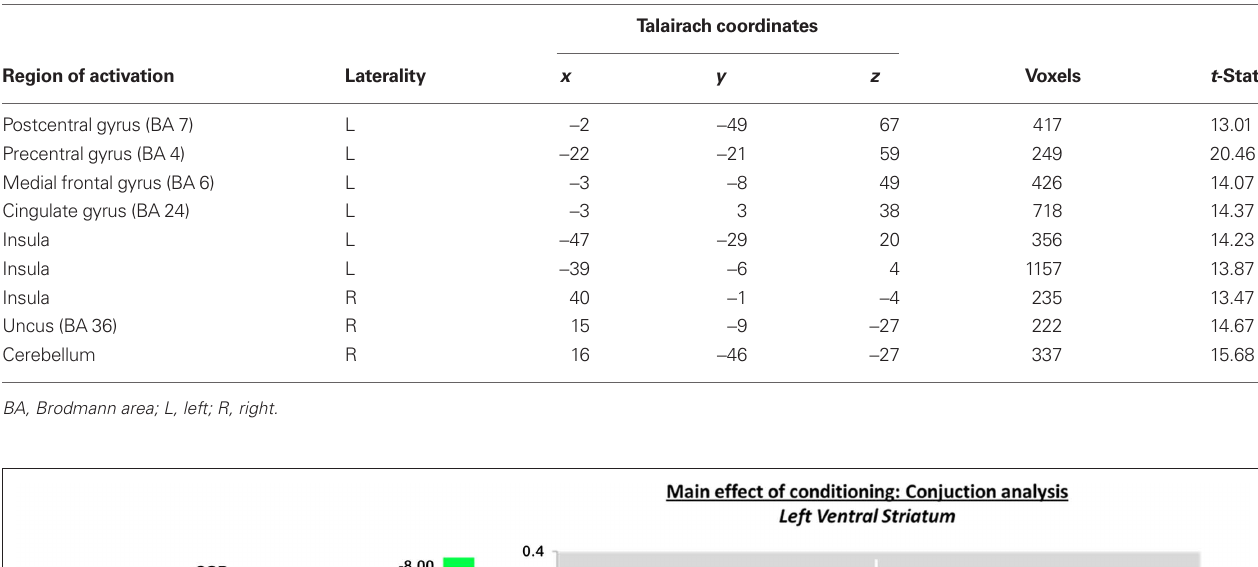
Table 2 | Probing differences in neural circuitry underlying aversive conditioning with primary and secondary reinforcers with an interaction of CS (CS + and CS − ) and session (primary and secondary; p < 0.005).